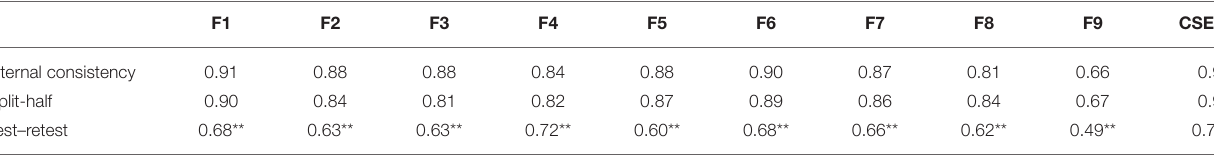
TABLE 6 | Reliability of the CSEFHQ (Internal consistency and split-half: N = 696; Test–retest: N = 223). F1 F2 F3 F4 F5 F6 F7 F8 F9 CSEFHQ Internal consistency 0.91